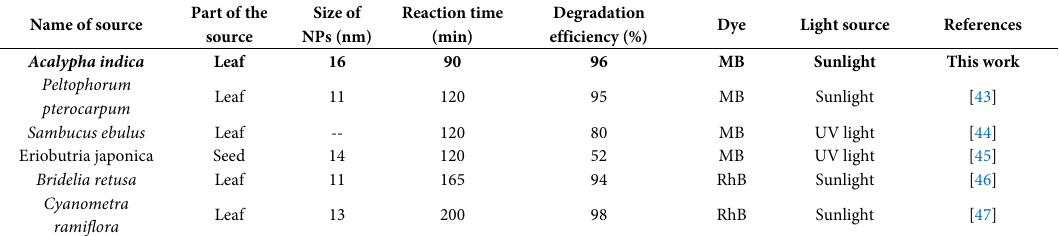
Table 2. The comparative assessment of photocatalytic activity of synthesized ZnO nanoparticles with existing